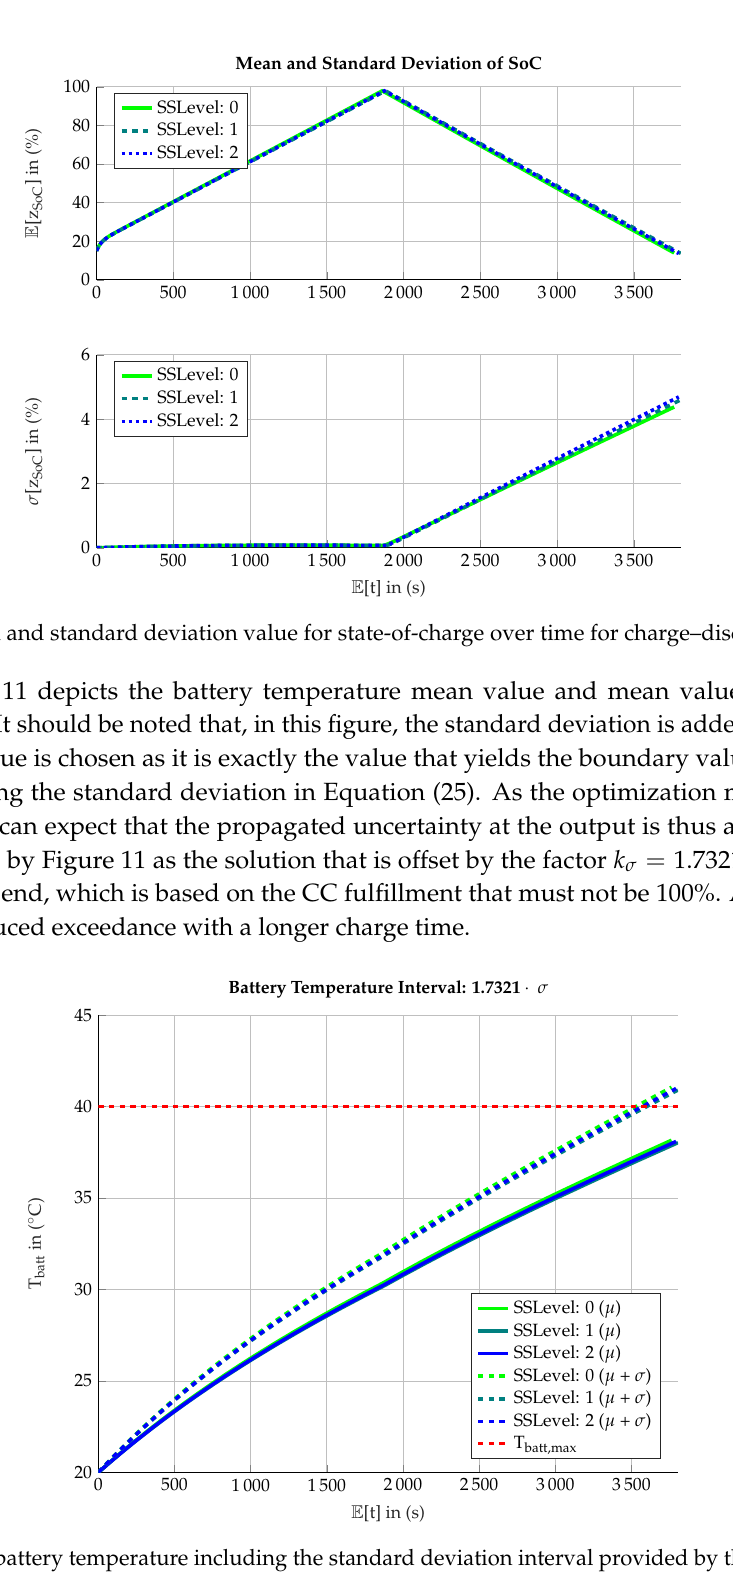
Figure 11. Mean battery temperature including the standard deviation interval provided by the underlying uniform parameter uncertainty over time for the charge–discharge